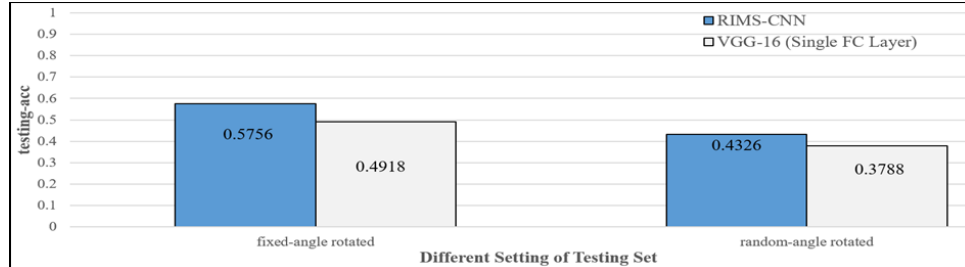
Figure 30. Evaluating RIMS-CNN and VGG-16 on the fixed-angle and random-angle rotated CIFAR-10.